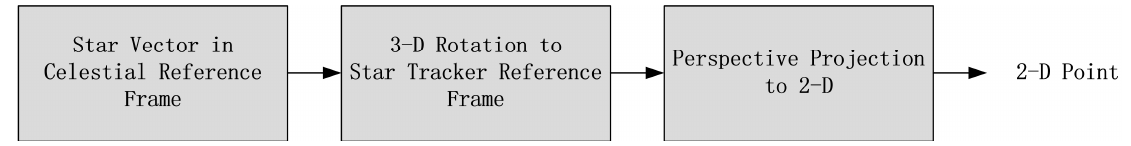
Figure 2. Measurement model of EKF.